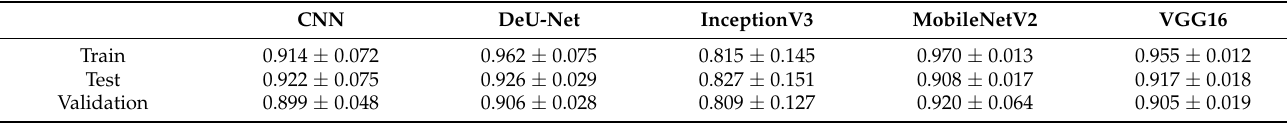
Table 4. Mean and SD of AUC with single modality images.